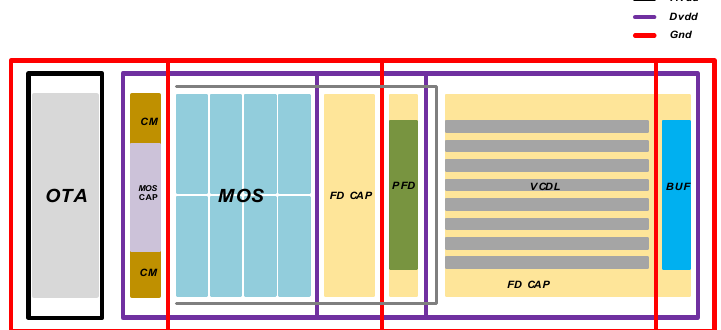
Figure 10. ADC overall layout design.